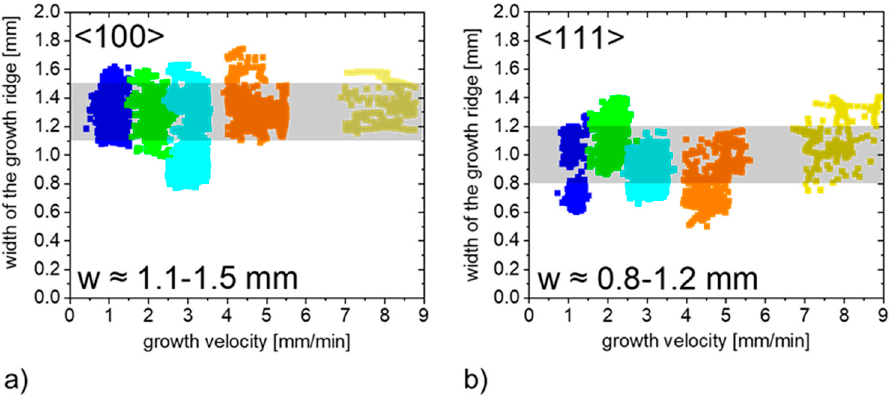
Figure 5. Growth ridge width w measured by surface topography in <100> ( a ) and <111> ( b ) dislocation-free silicon crystals grown by the FZ technique for various growth velocities.